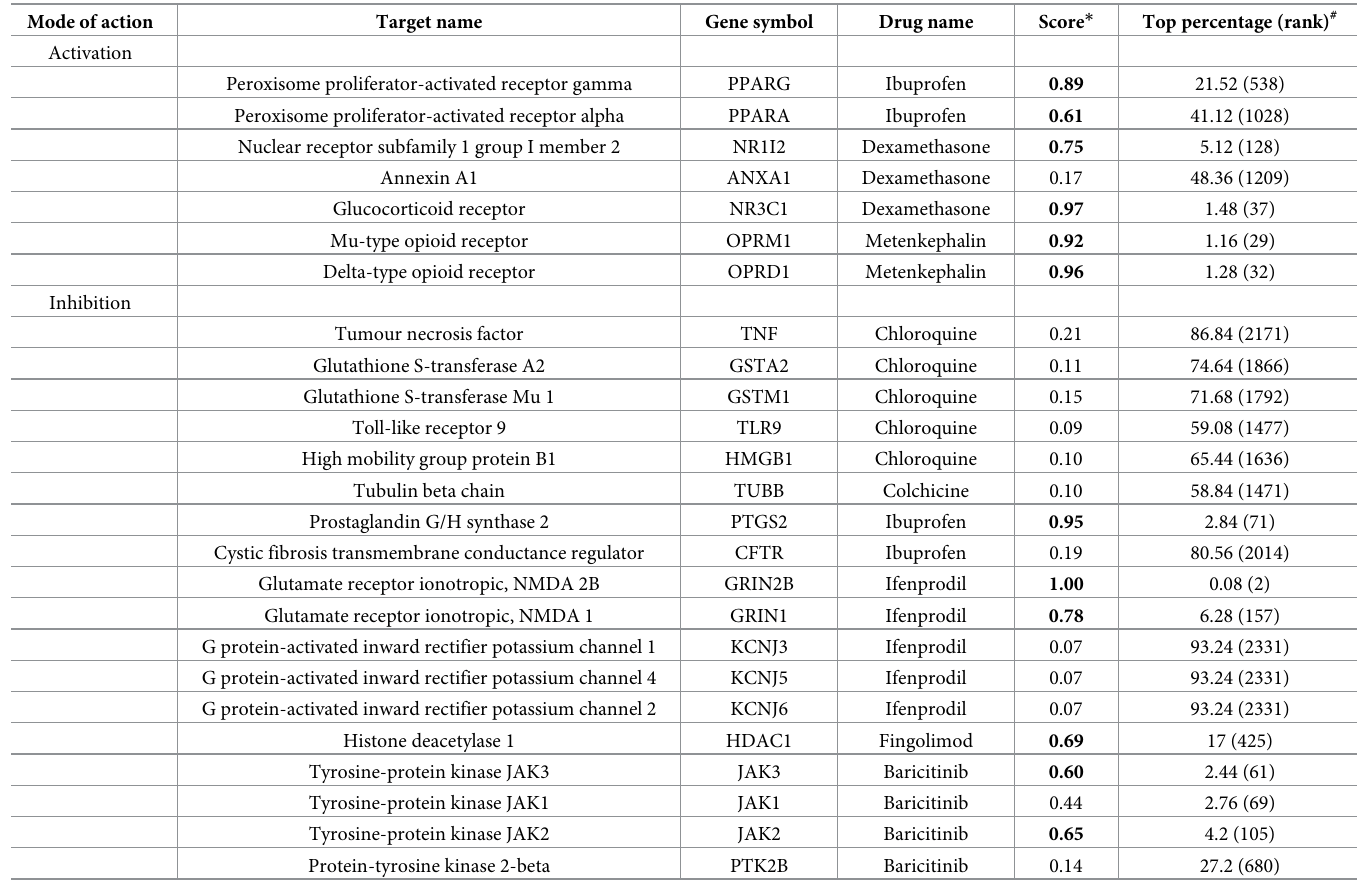
Table 5. Predicted results for validated DTIs related to